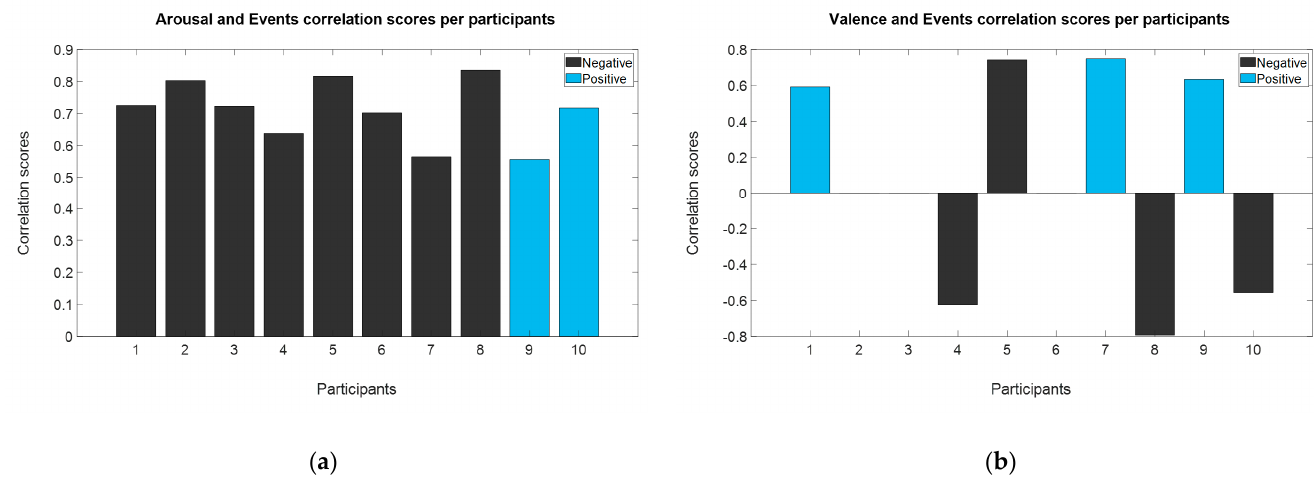
Figure 5. Correlation between arousal–valence scores and number of events per game level. ( a ) Arousal correlations. ( b ) Valence correlations.